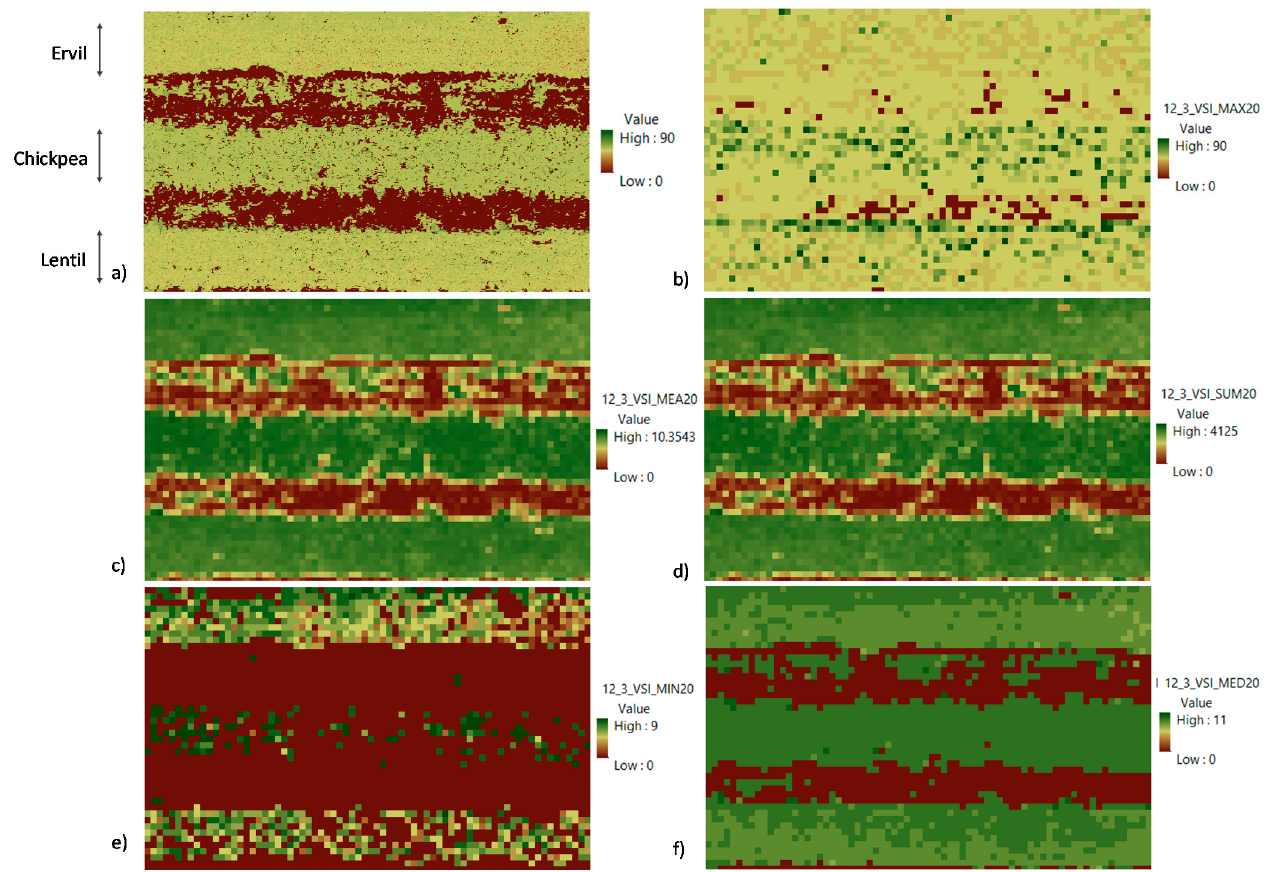
Figure 5. Results of selection of best aggregation technique using the example of results with the first repetition at 12 m. ( a ) VSI; ( b ) aggregation technique = Maximum; ( c ) aggregation technique = Mean; ( d ) aggregation technique = Summation; ( e ) aggregation technique = Minimum; ( f ) aggregation technique = Median. The crops in the images from top to bottom lines are ervil, chickpea, and lentil.